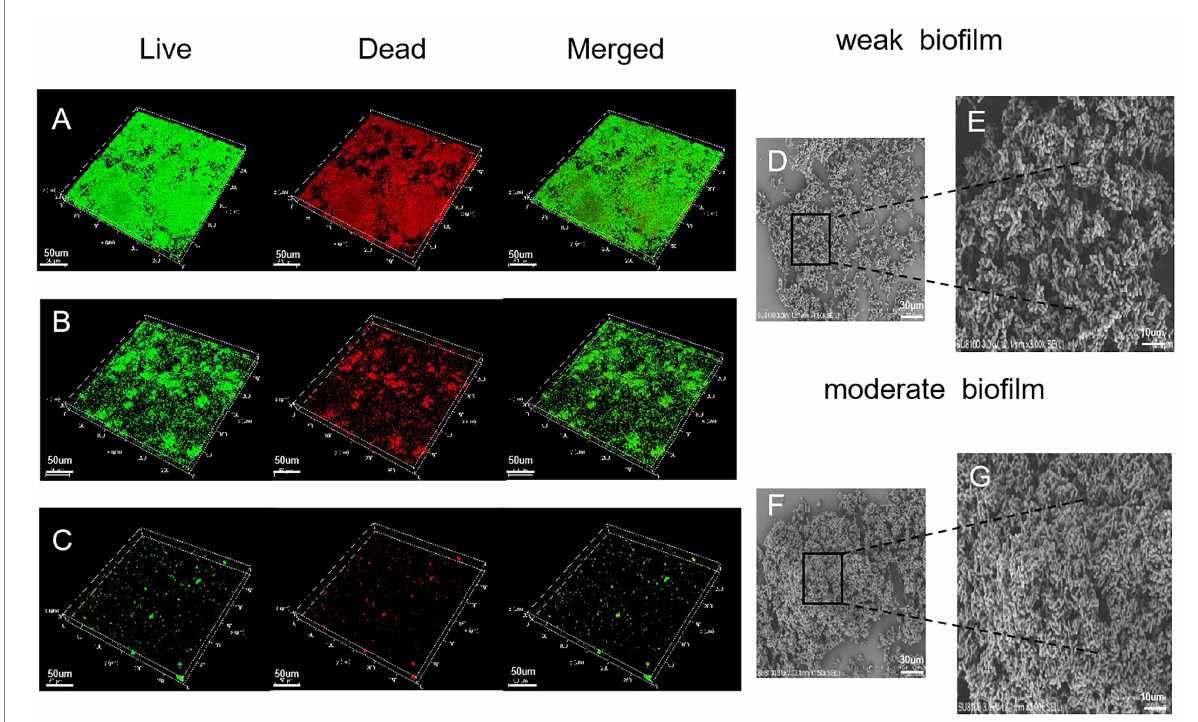
FIGURE 2 Microscopic structure of the biofilm, as determined by CLSM (×400 magnification). (A) Moderate biofilm detected by Live/Dead® viability staining; the green color indicates live cells and the red color indicates dead bacteria. (B) A strain that produced a weak biofilm. (C) A strain that produced no biofilm. (D) SEM images (×1,500 magnification) illustrating a weak biofilm. Scale bars represent 30 μ m. (E) SEM images (×3,000 magnification) illustrating a weak biofilm. Scale bars represent 10 μ m. (F,G) SEM images of moderate